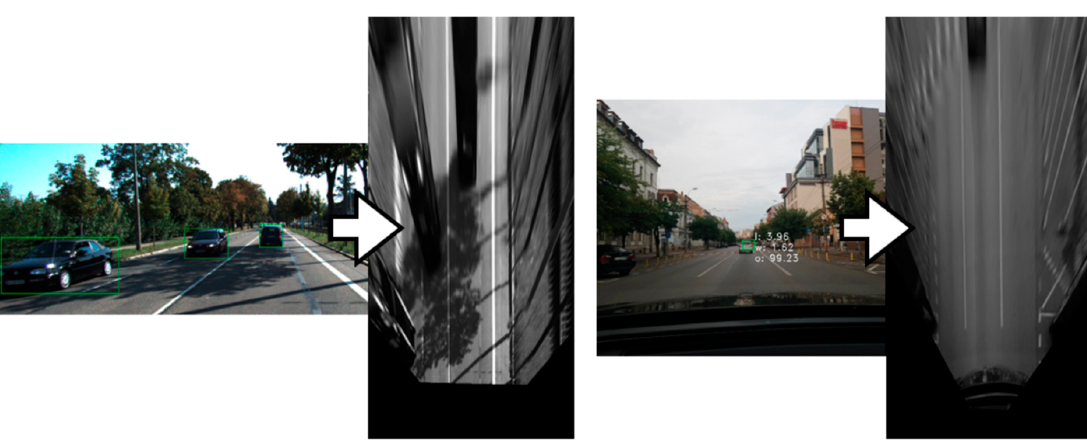
Figure 14. Generating the Inverse Perspective Mapping (IPM) image using the calibration data.